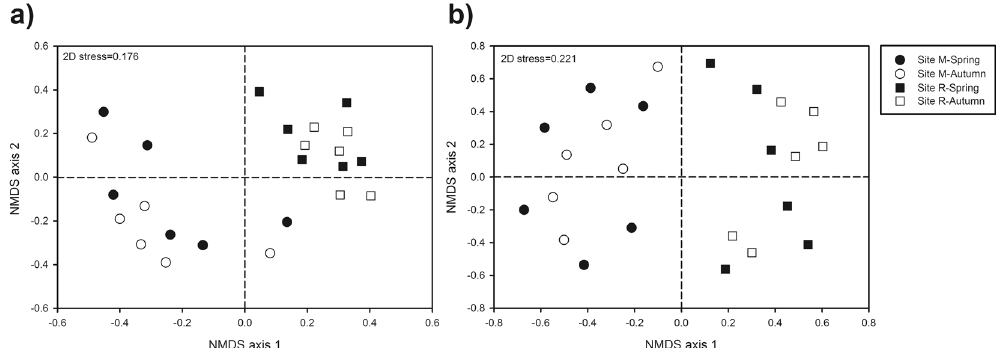
Figure 2. Nonmetric multidimensional scaling (NMDS) ordinations based on Bray-Curtis similarities of OTU- based bacterial ( a ) and fungal ( b ) community structures found at the deciduous forest site M (545–570 m asl) and the coniferous forest site R (1,724–1,737 m) in spring and